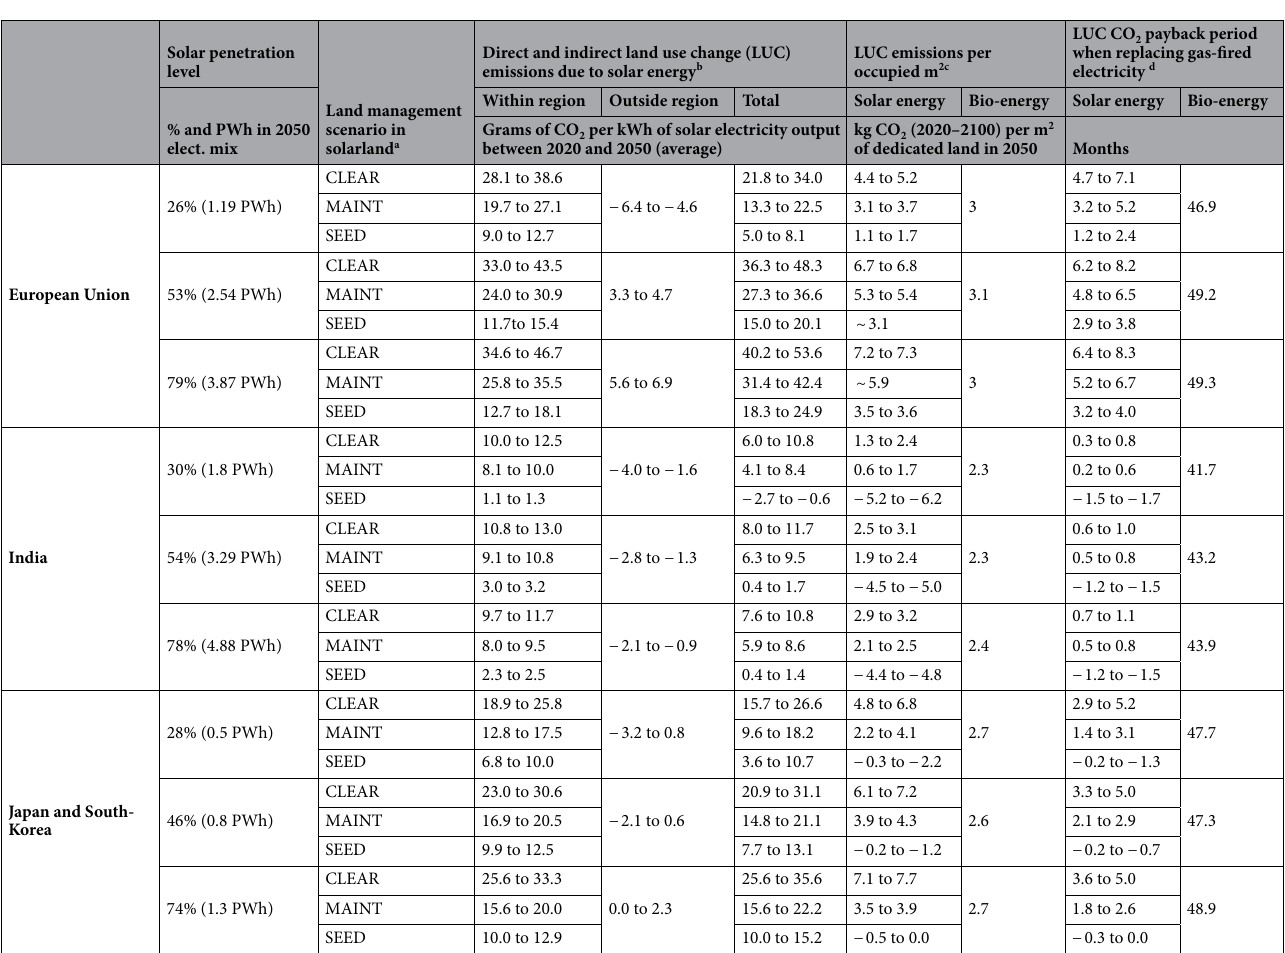
Table 2. Land use change emissions and payback periods for solar penetration and solarland management scenarios. Ranges show results for with different future solar module efficiencies with left values within each solar-related column representing 28% efficiency and right values 20%. Results for bioenergy scenarios included for comparison. a CLEAR: permanently clearing land vegetation; MAINT: Maintain/restore previous vegetation (up to 30 cm); SEED: Seeding and management as pastures. See “Methods” section for a detailed description of these land management scenarios. b Dividing all LUC emissions from 2020 to 2050 to the total amount of generated electricity (including non-land-based sources, such as solar rooftops, unproductive land or waste-to-energy plants for bioenergy). c Dividing all LUC emissions from 2020, including delayed carbon release or sequestration until 2100, by the total land area dedicated to solar and bioenergy by 2050 (maximum point). Negative values indicate net carbon sequestration for every m 2 of solarland. d Calculated assuming